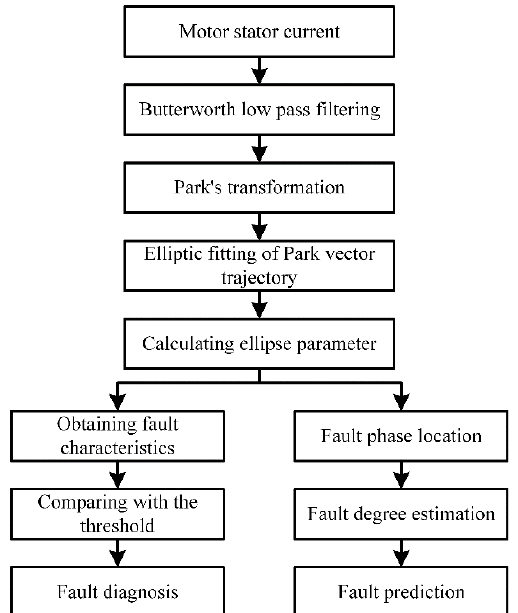
Figure 4. Flow chart of diagnosis and prediction method of stator interturn short-circuit